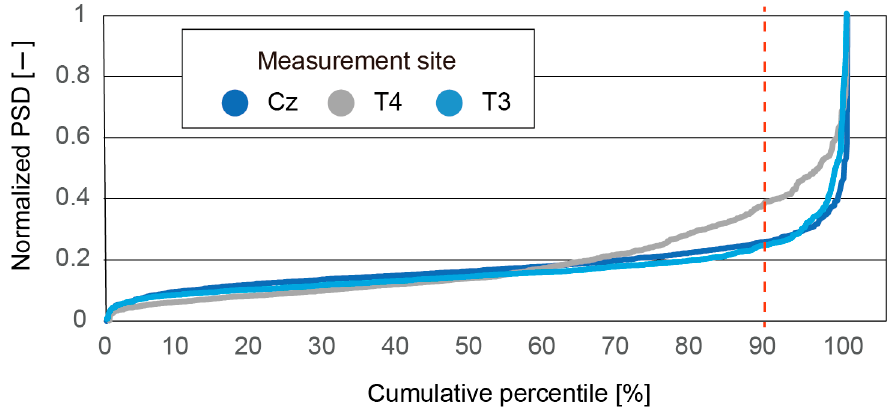
Figure 11. Cumulative percentile of normalized PSD of high- β / α measured at Cz, T4, and T3 for participant C. PSD is normalized by maximum